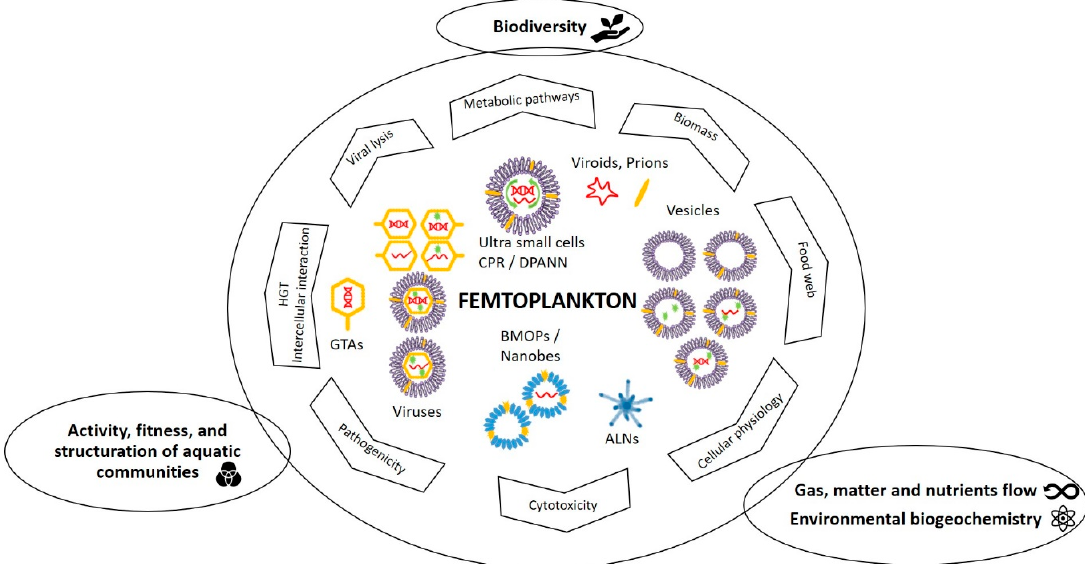
Figure 8. Schematic overview of the specific and major ecological roles of femtoplankton entities mentioned in this review. BMOPs = Biomimetic mineral-organic particles, ALNs = aster-like nanoparticles, CPR/DPANN = Candidate Phyla Radiation/Diapherotrites Parvarchaeota AenigmarchaeotaNanoarchaeota Nanohaloarchaeota, GTAs = gene transfer agents, HGT = horizontal gene